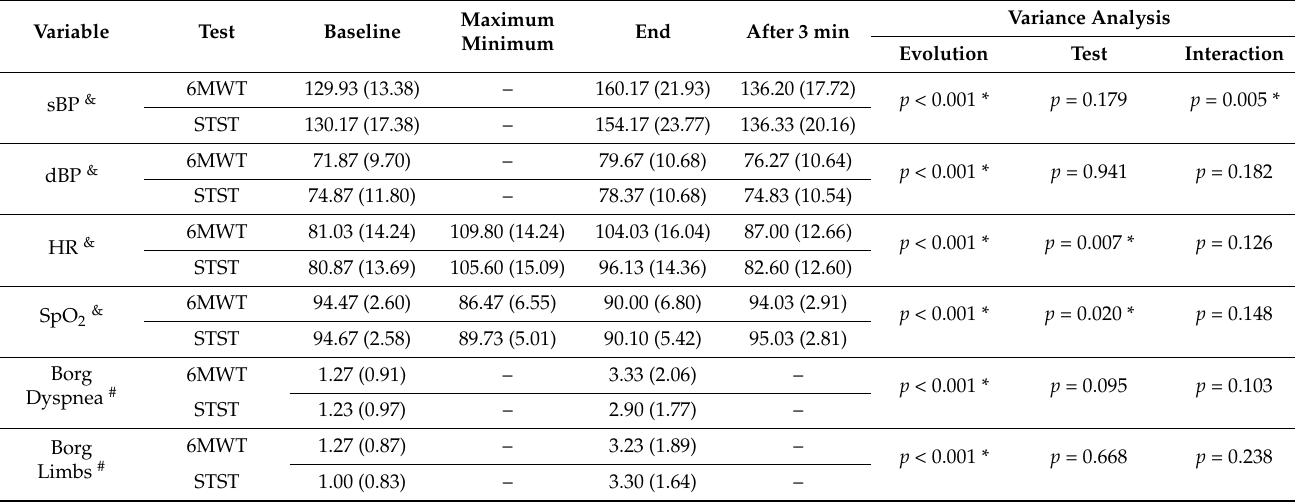
Values represented as mean and standard deviation; & quadratic adjustment; # linear adjustment; * statistically